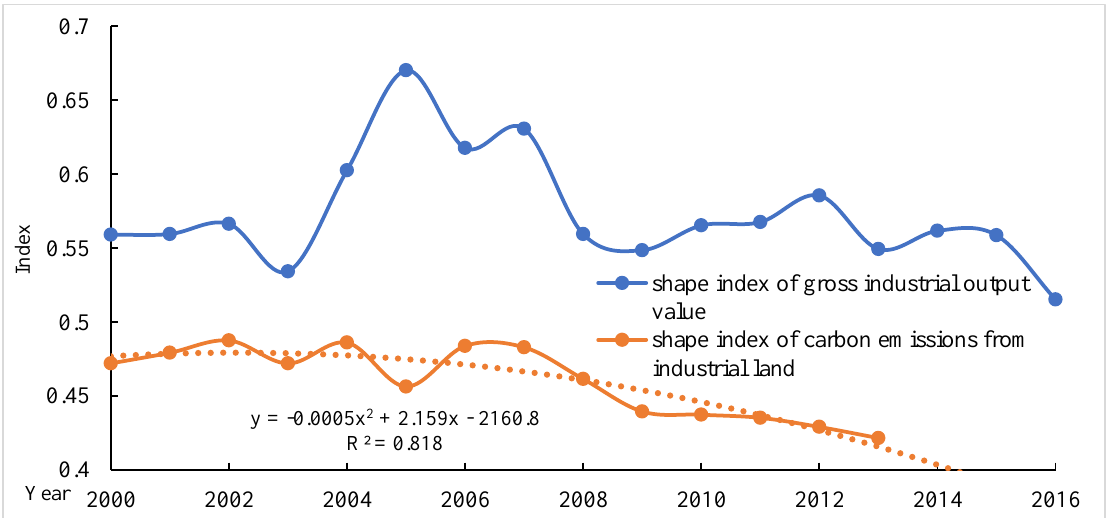
Note: Shape index = y-axis standard deviation/x-axis standard deviation.